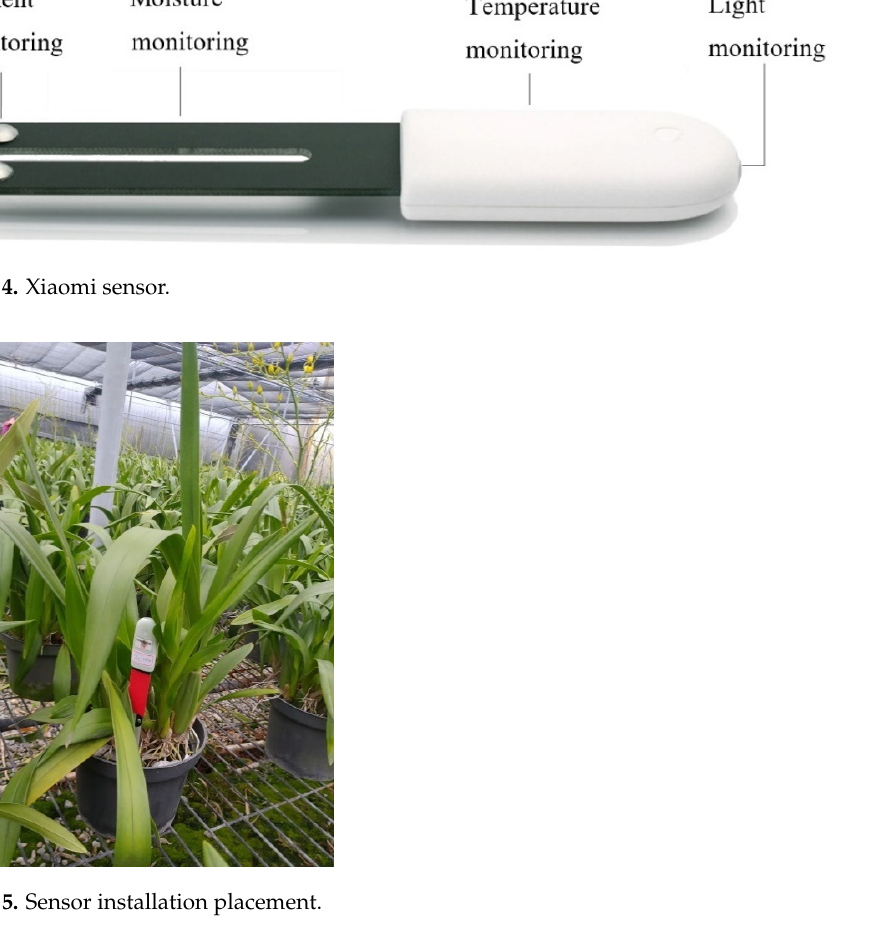
Figure 4. Xiaomi sensor. Table 2. Parameters of the Xiaomi sensors.